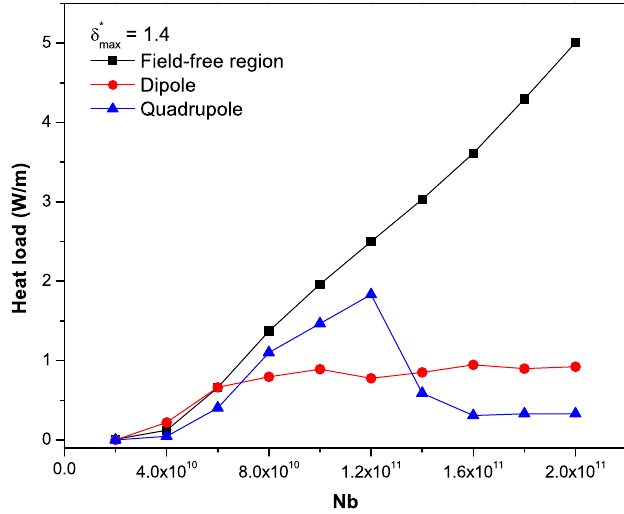
FIG. 6. Simulated heat load in the LHC as a function of bunch population and different sections, for 25-ns bunch